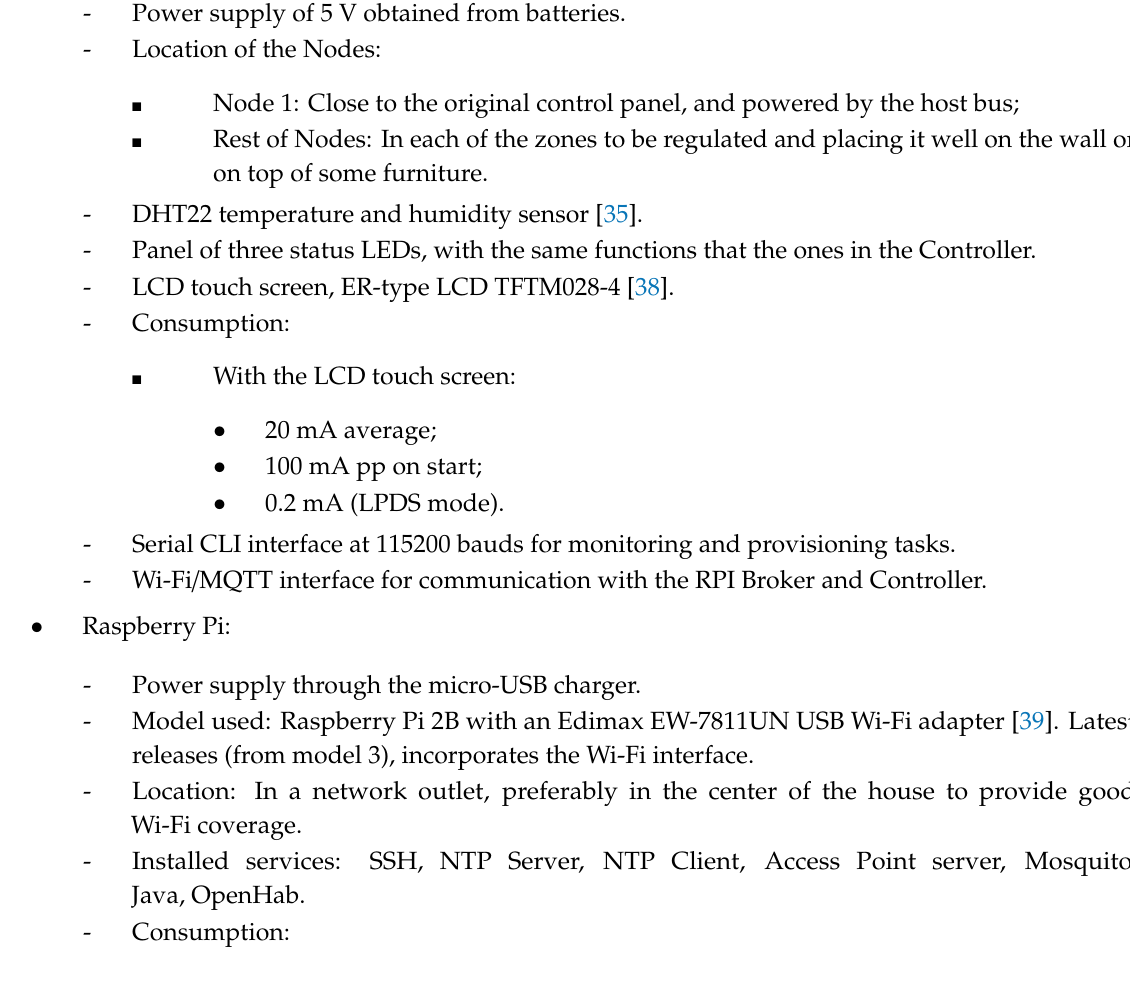
2.5A pp with the 4 servo motors